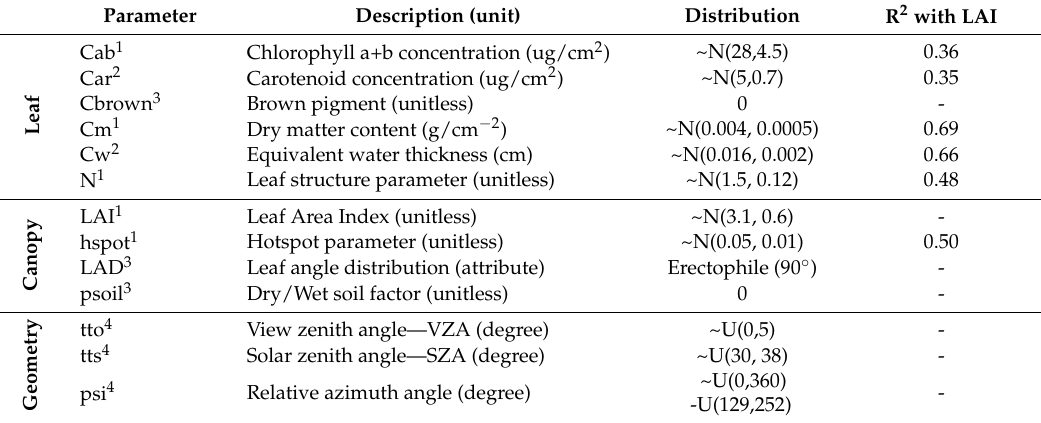
1 simulated from plant traits by levels of spatial dependency and rescaled to present a Normal distribution ~N (mean, standard deviation). 2 a function of another parameter: Car = Cab/5 and Cw = 4/Cm − 1 . 3 fixed values for all landscapes. 4 generated randomly from a uniform distribution with max and min ~U(min,max), varying according to hypothetical in situ measurements using a field spectrometer: where tto is the deviation from nadir (0 ◦ ); tts = 90 ◦ minus the max and min sun altitude, and psi = ~U(0,360) minus the max and min solar zenith angle during the